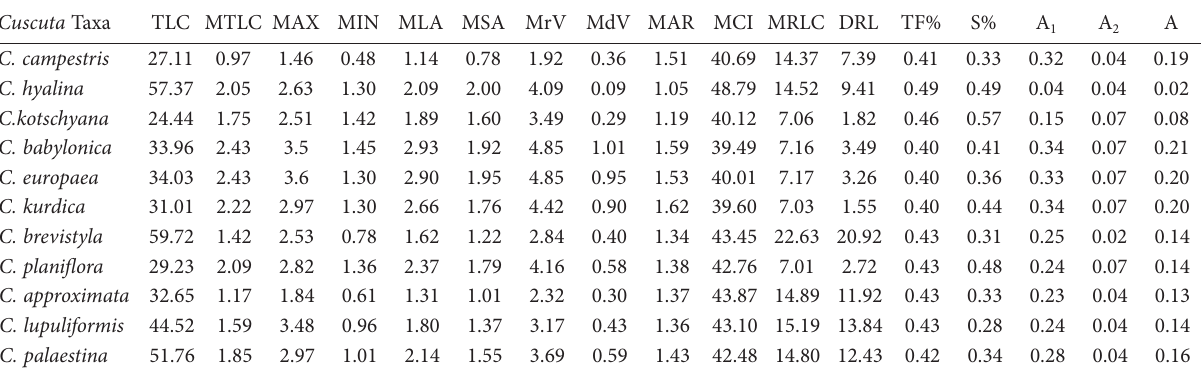
Table 3. Karyotype characteristics of Cuscuta taxa (TLC: Total Lenght of Chromosomes, MTLC (Mean of Total Length of Chromosomes, MAX: Maximum Length of Chromosome, MIN: Minimum Length of Chromosome, MLA: Mean of Long Arms, MSA: Mean of Short Arms, MrV: Mean of r Value, MdV: Mean of d Value, MAR: Mean of Arm Ratio, MCI: Mean of Chromosome Index, MRLC: Mean of Rela- tive Length of Chromosomes, DRL: Difference of Range of Relative Length, TF%: Total Form Percentage, S%: Relative Length of Shortest Chromosome, A 1 : Intrachromosomal Asymmetry Index, A 2 : Interchromosomal Asymmetry Index). Cuscuta